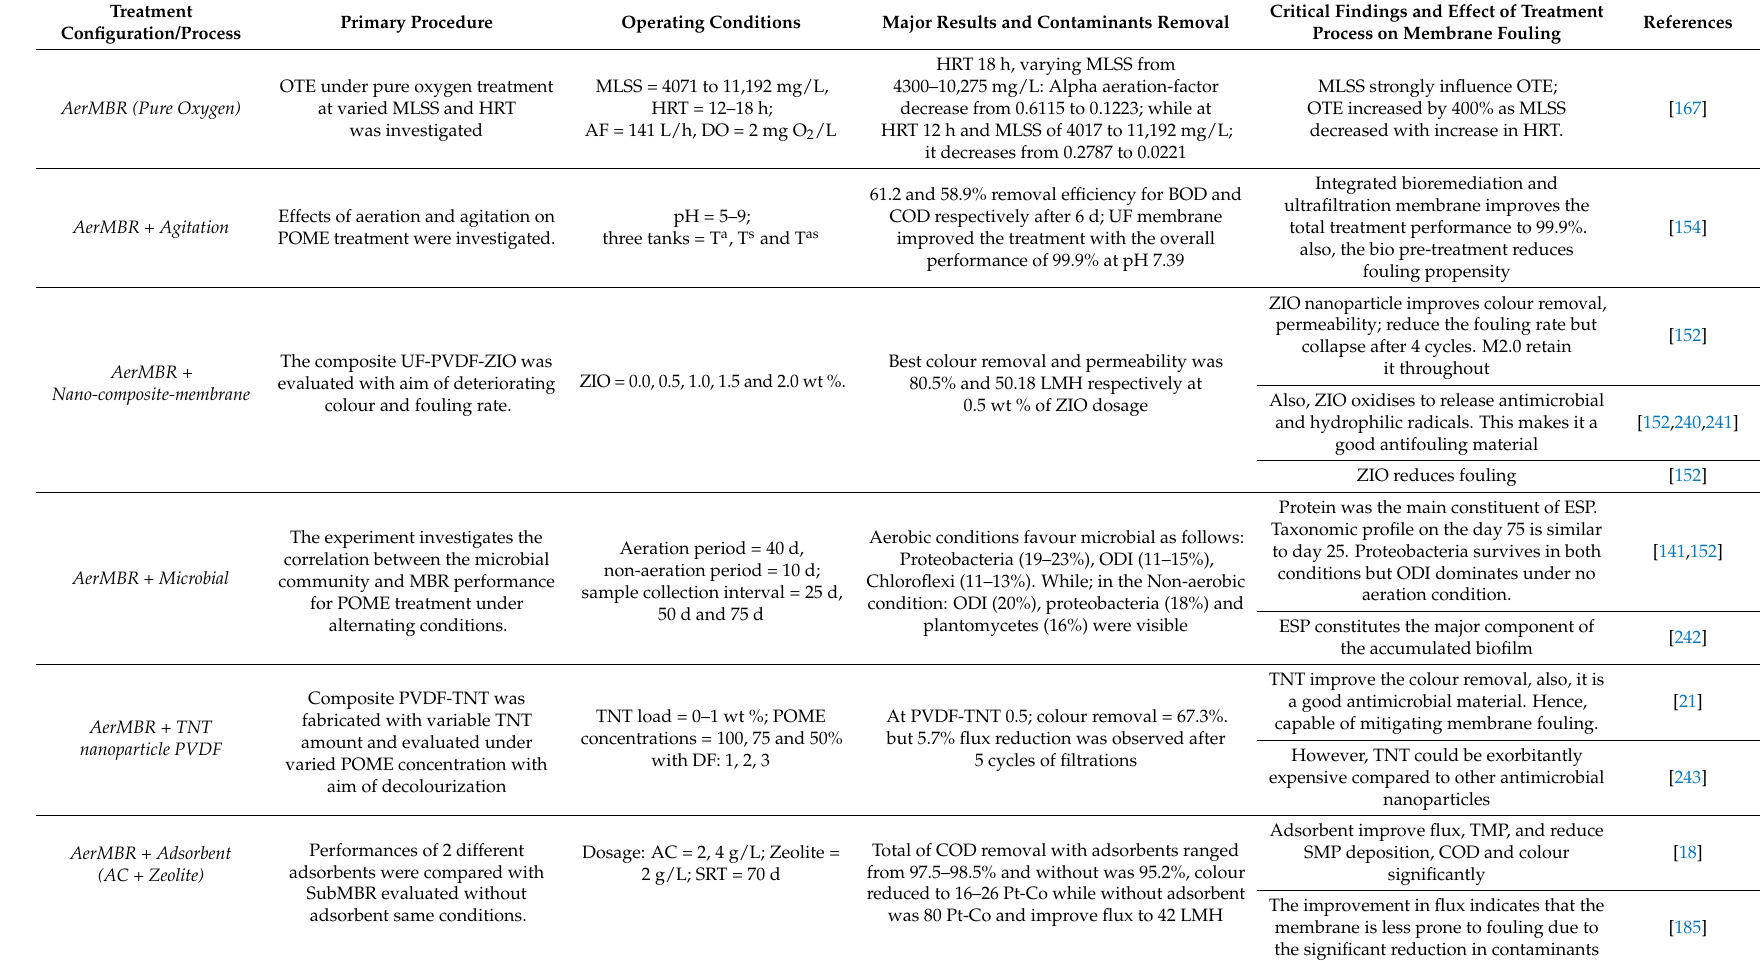
Table 3. Summary of the published processes for POME treatments using membrane